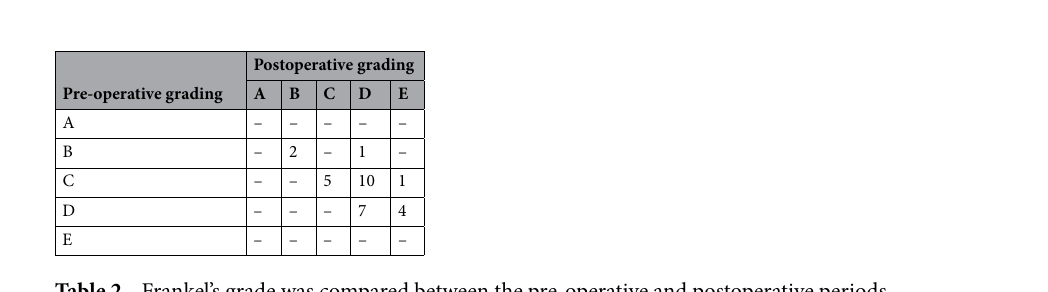
Table 2. Frankel’s grade was compared between the pre-operative and postoperative